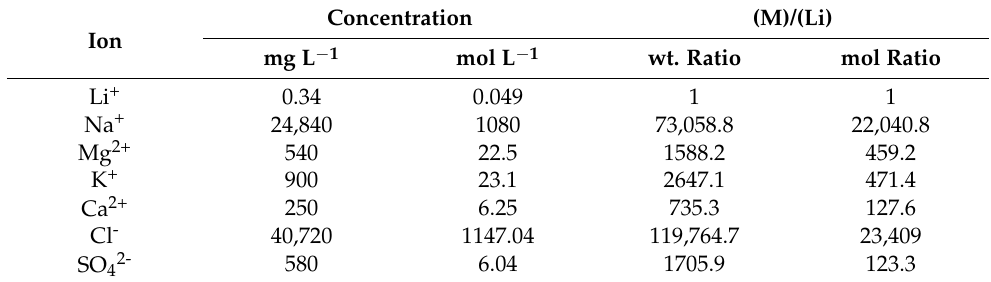
Table 1. Chemical composition of a simulated 1st pass SWRO brine operating at 50% efficiency. Concentration (M)/(Li) Ion mg L − 1 mol L −